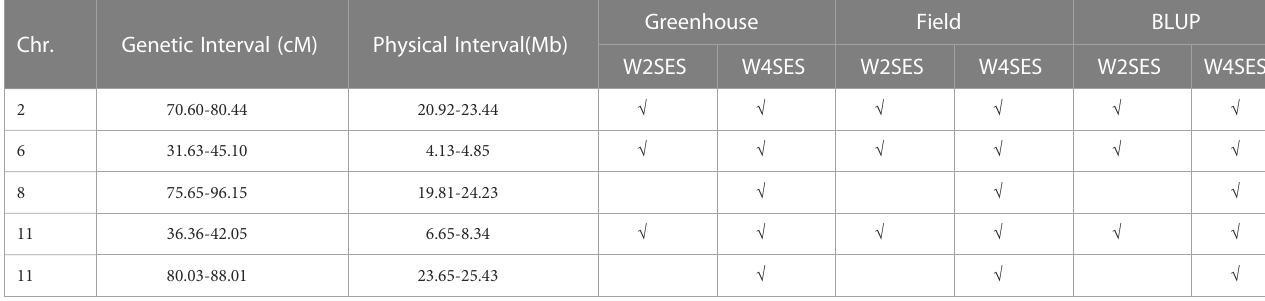
TABLE 4 Comparing QTL con fi dence interval among greenhouse, fi eld and BULP.